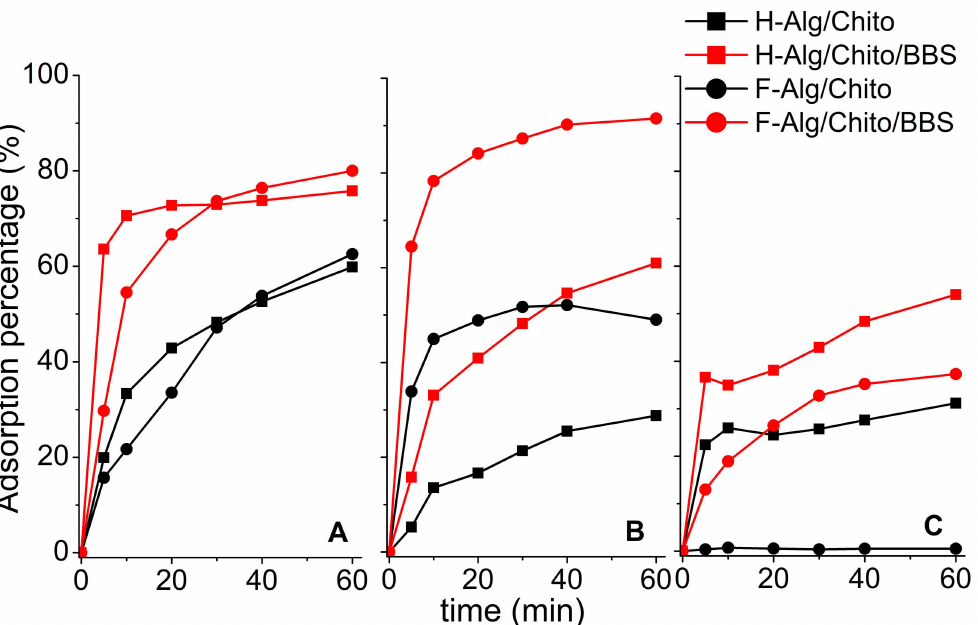
Figure 8. Adsorption percentages of both hydrogels and dried films towards di ff erent substrates: ( A ) crystal violet - CV, ( B ) rhodamine B - RH, and ( C ) orange II – OII at initial dye concentration of 10 mg L − 1 . Legend: H-Alg / Chito (black squares, black line), H-Alg / Ca / BBS (red squares, red line), F-Alg / Chito (black circles, black line), and F-Alg / Chito / BBS (red circles, red line). Adsorption percentages were calculated by means of UV-VIS spectroscopy, considering the adsorption peak decrease respect to the bare solution at time 0. Wavelengths selected were 590 nm (CV), 555 nm (RH), and 485 nm